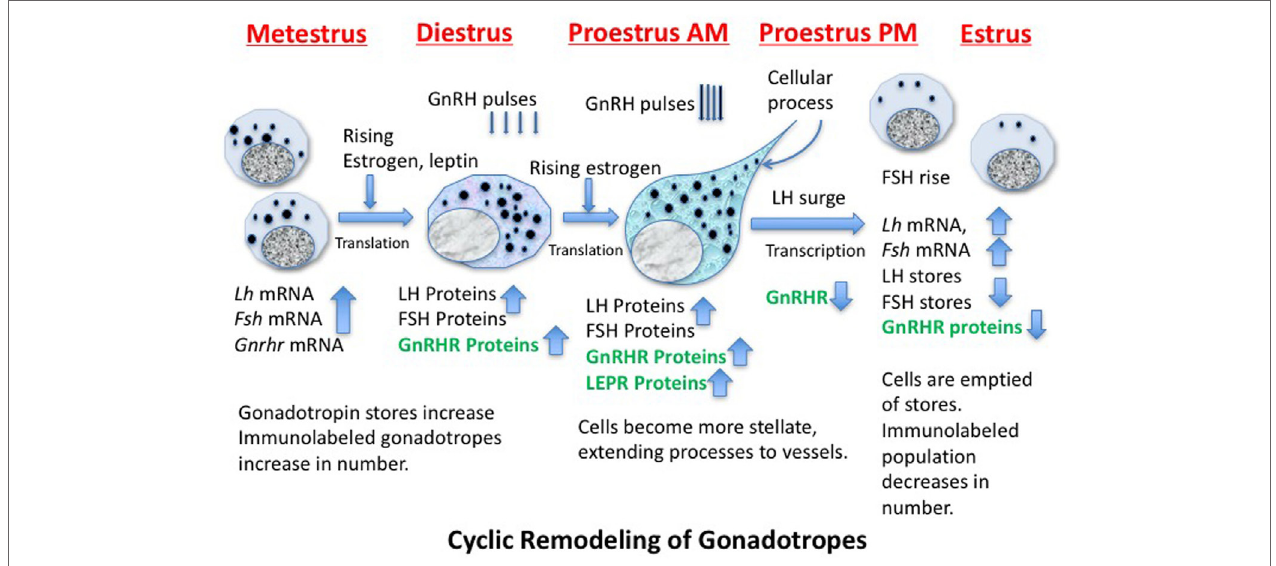
FiGUre 2 | Cartoon showing stages of remodeling in the population of gonadotropes destined to support the luteinizing hormone (LH) surge secretory activity during proestrous and early estrus. The activity is driven by GnRH pulses, which increase in frequency and amplitude before the LH surge. The timing of the production of critical gene products is noted and those in green are known to be leptin